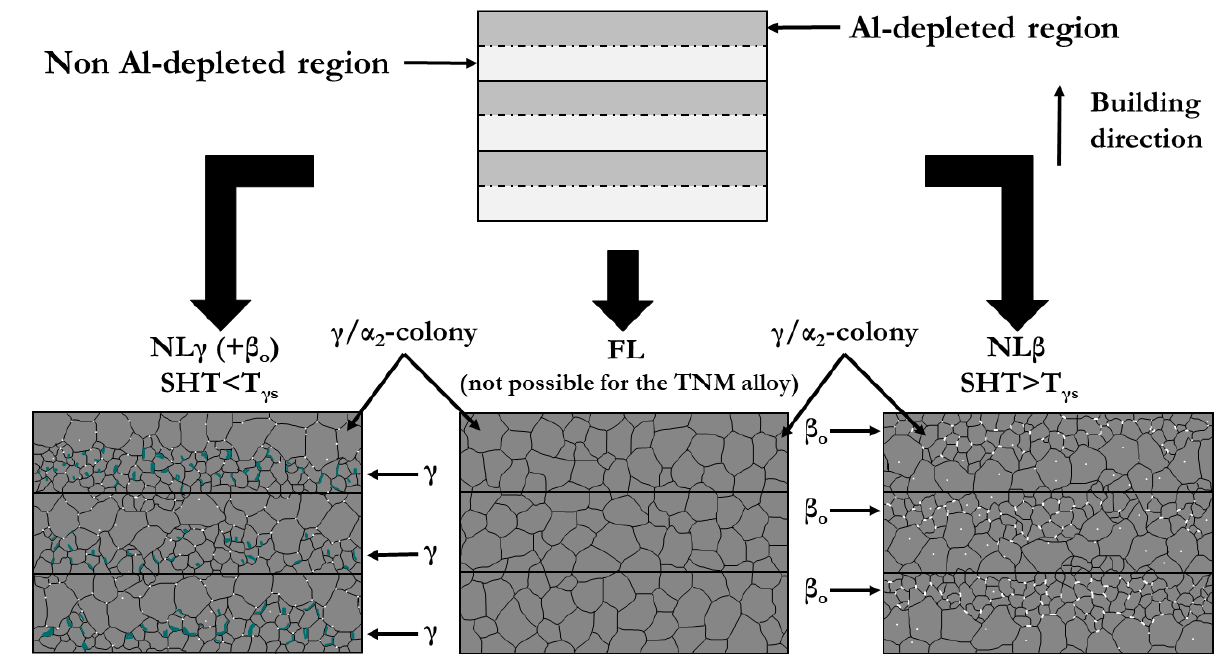
Figure 6. Schematic explanation of the formation of banded microstructures during a solution heat treatment of LPBF-TNM and LPBF-TNM + specimens conducted in the proximity of T γ S . The underlying heterogeneous Al-distribution due to Al evaporation leads to layered phase distributions of either γ (+ β )-phase (SHT<T γ S ) or solely β -phase (SHT>T γ S ), inducing abnormal grain growth of the α -grains in those regions, where only a small amount of either γ (+ β ) or β as second-phase particles are present. Adjusting a “classic” FL microstructure is impossible for the TNM and TNM + alloys as the alloys show no required α -single phase field region (see Figure 4). The building direction in this illustration is vertical.